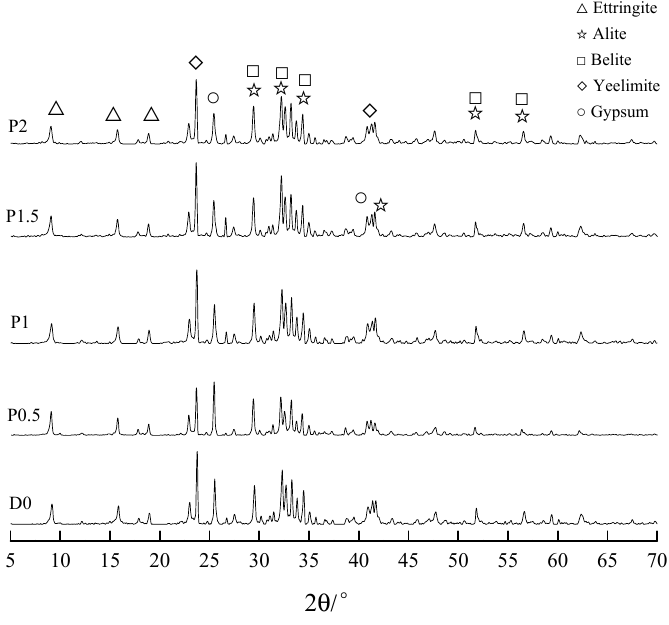
Figure 10. XRD patterns of composite cement at 28 d.